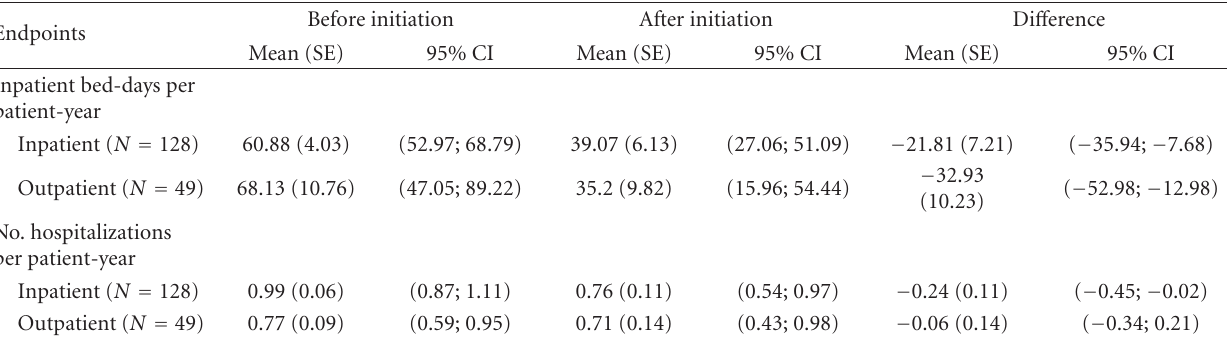
Table 6: Results of the subgroup analysis for the endpoints: inpatient bed-days per patient and year, and number of hospitalisations per patient and year. Results are presented for subgroups of patients who are in- or outpatients at the time of initiating RLAI.